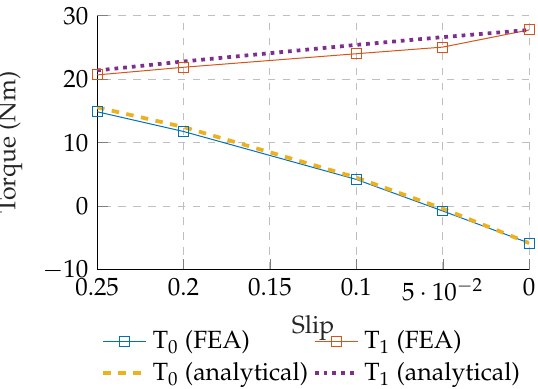
Figure 11. Steady state torque characteristics of the second prototype.